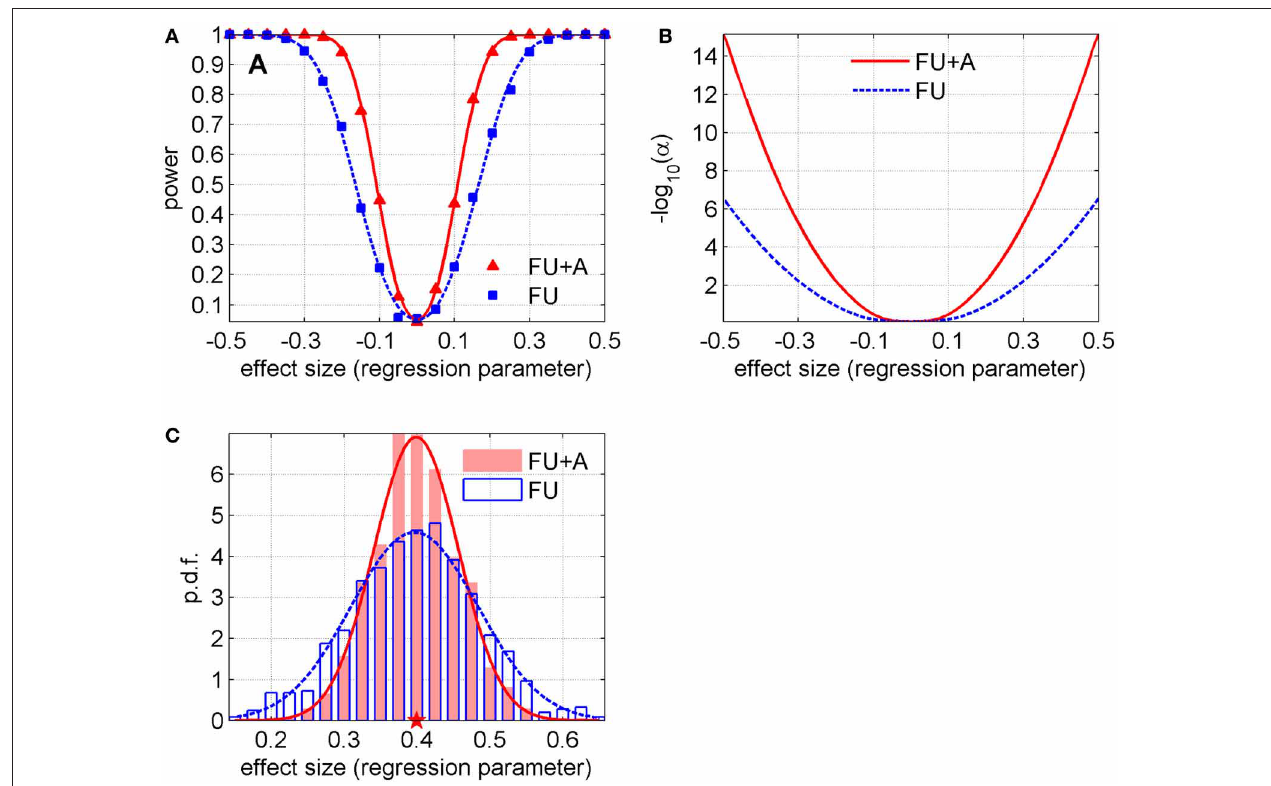
FIGURE 1 | (A) Power in two methods described in the text (with follow-up only, “FU,” and follow-up and ages at biospecimen collection, “FU + A”) for different effect sizes (i.e., values of the regression parameter γ ) and fixed α = 0 . 05; the lines denote the fit of the empirical curves by the power curves of a one-sample Z-test of the mean (the standard deviations that produced the best fit are 0.056 for “FU + A” and 0.084 for “FU”). (B) The level of the test [shown as − log 10 ( α ) for better visibility] that yields power w = 0 . 8, as a